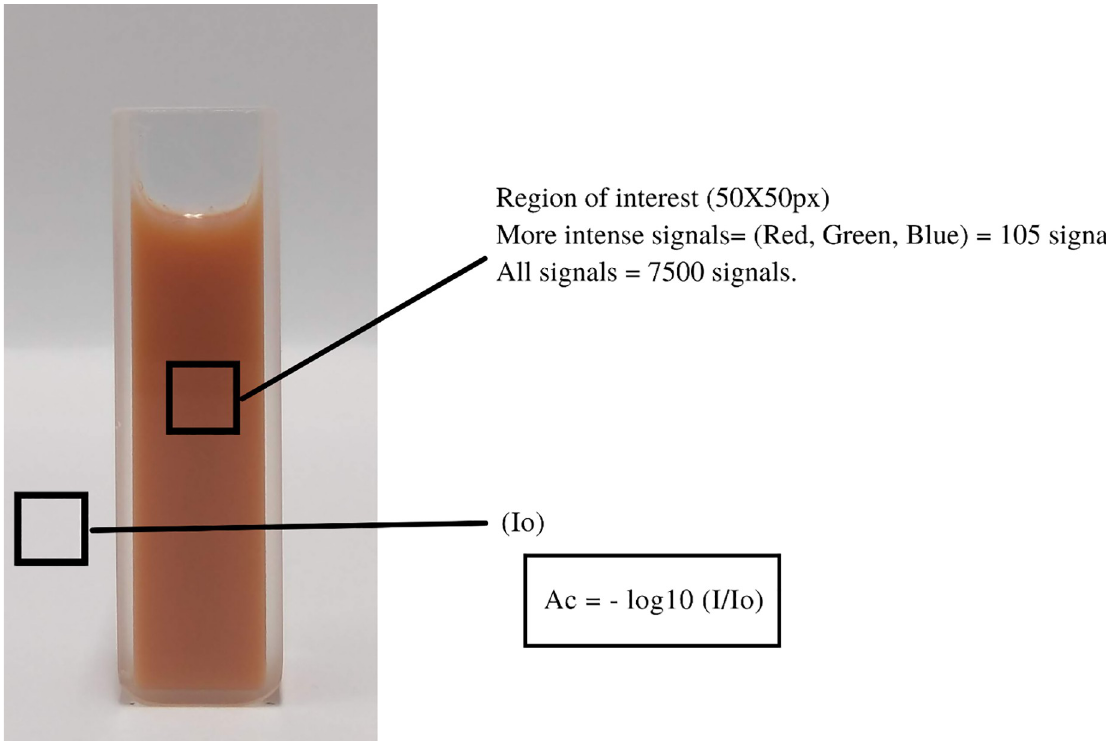
Fig 2. Spots of the region of interest (ROI) for image processing. Here we denote the 2 ROIs as the blank (left) and sample (right).